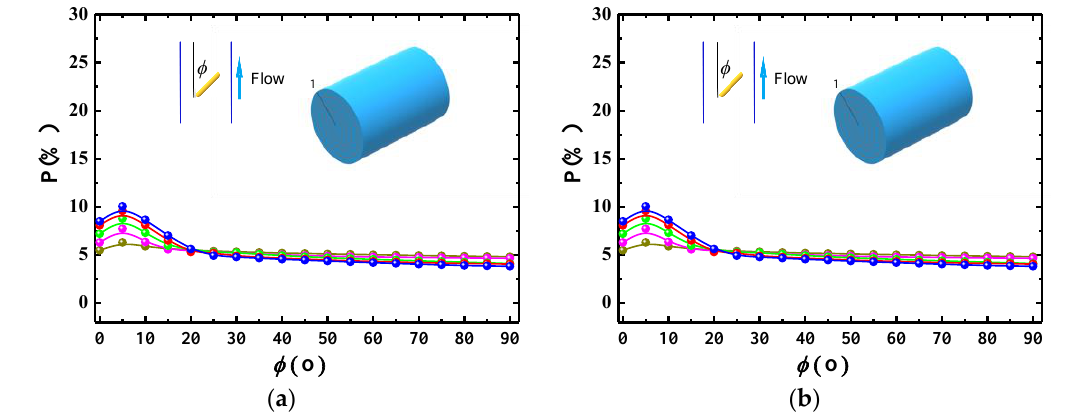
Figure 9. Distribution of mean particle orientation in region 1 and 5 for different Reynolds numbers ( λ = 8, L/D = 200). ( a ) Region 1 and ( b ) region 5. ●: Re = 5000; ●: Re = 10,000; ●: Re = 20,000; ●: Re = 30,000; ●: Re = 40,000.